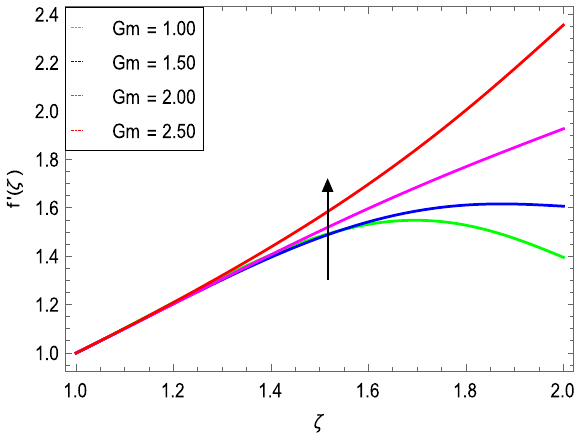
Figure 6. f ′ (ζ) as a function of Gm .